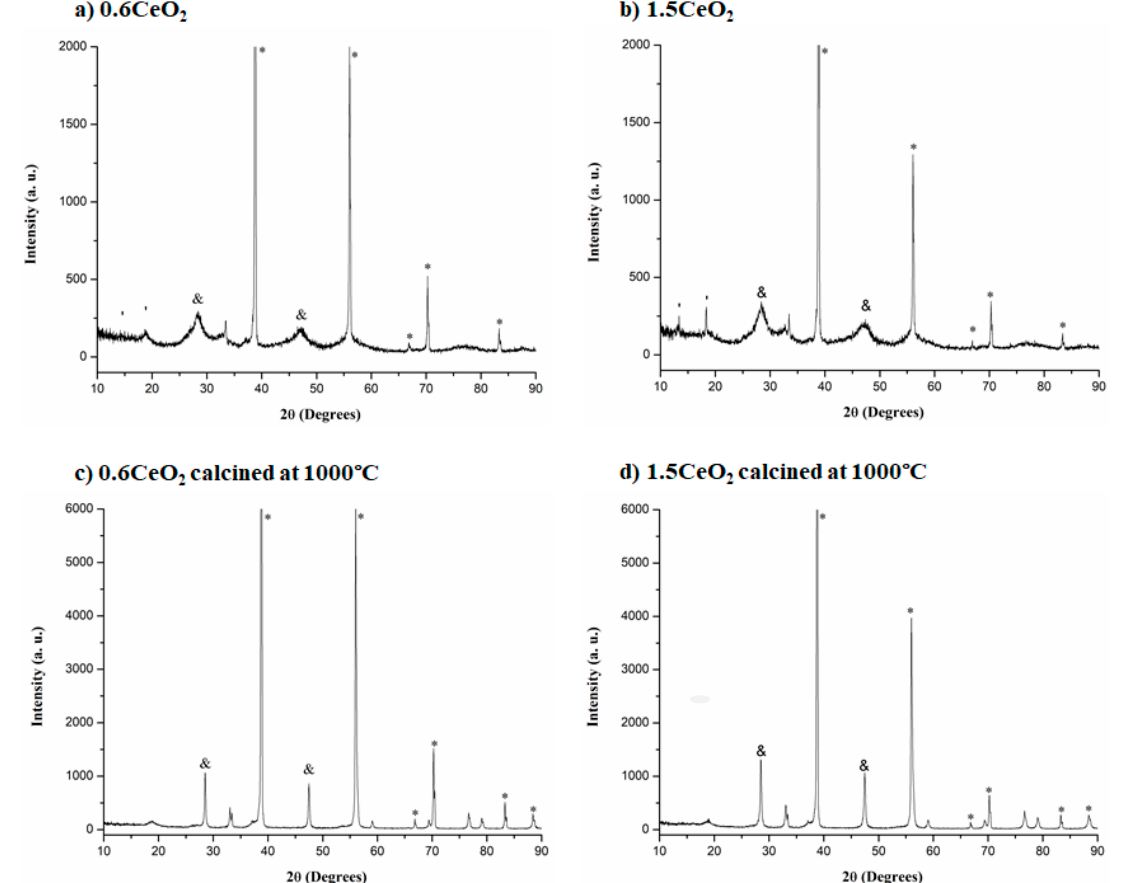
Figure 3. XRD patterns of ( a ) 0.6CeO 2 , ( b ) 1.5CeO 2 , ( c ) 0.6CeO 2 and ( d ) 1.5CeO 2 calcined at 1000 ◦ C. The marked peaks belong to: * NaF (support), & ceria and ‘cerium (III) oxalate hydrate.